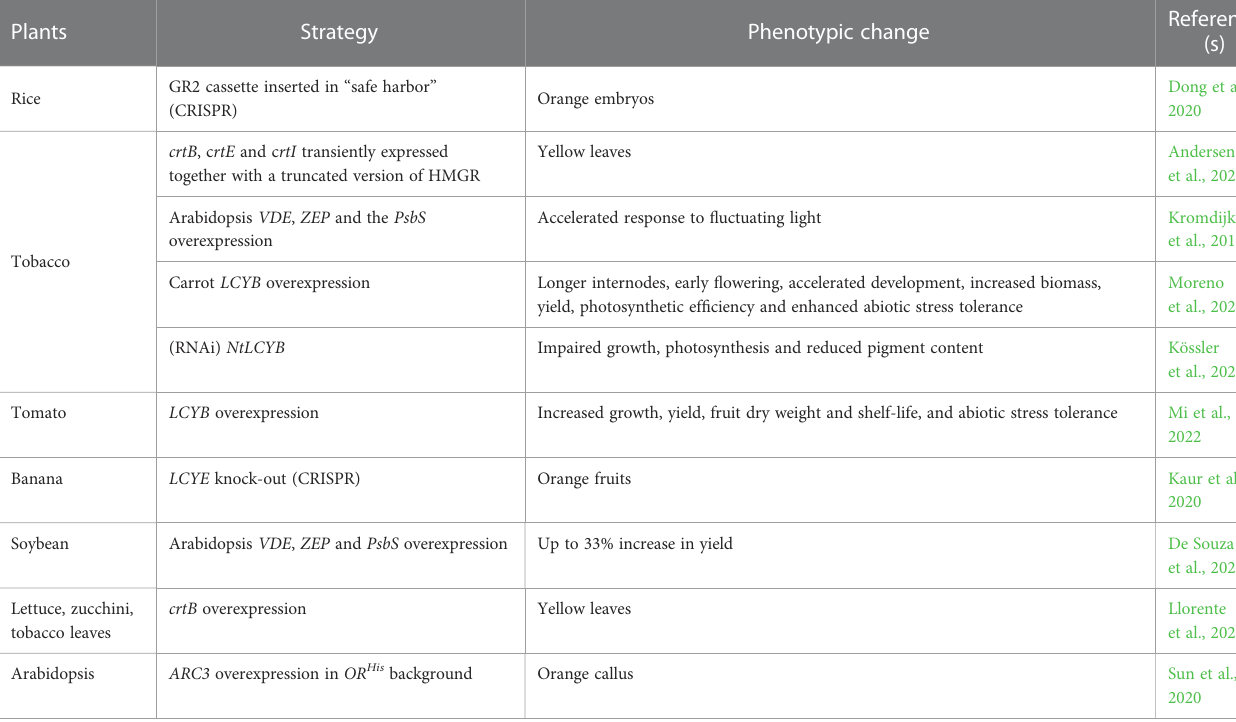
TABLE 1 Recent advances in carotenoid bioforti fi cation and metabolic engineering.